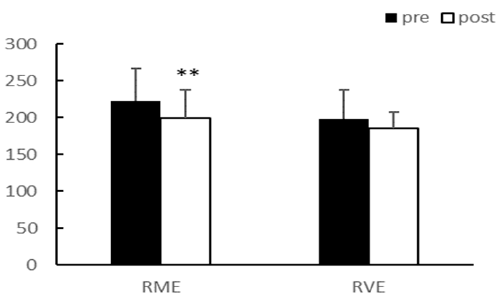
Figure 3. TC (mg/dL). TC, Total cholesterol; ** p < 0.01.